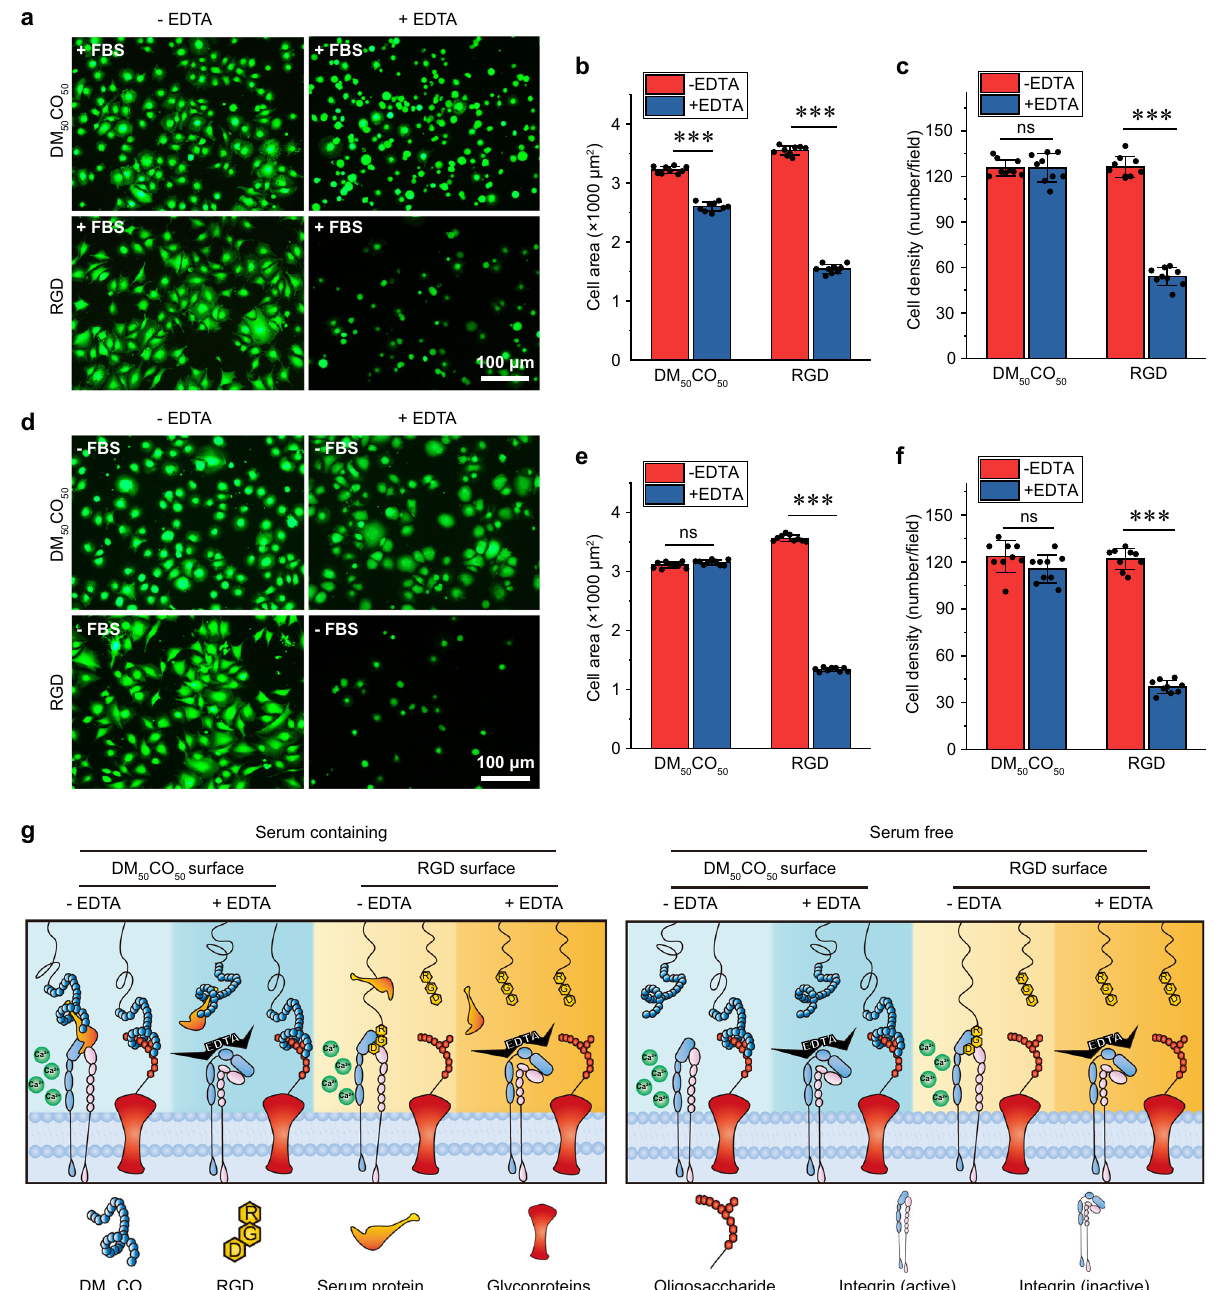
Fig. 4 Cells adhesion via both integrin-dependent and -independent mechanisms. a Fluorescent micrographs of live/dead stained cells, b cell area analysis, and c cell density analysis, of cell adhesion to DM 50 CO 50 and RGD-modi fi ed surfaces in serum-containing media for 3 h, with or without EDTA treatment. d Fluorescent micrographs, e cell area analysis, and f cell density analysis, of cell adhesion to DM 50 CO 50 and RGD-modi fi ed surfaces in serum- free media for 3 h, with or without EDTA treatment. g Cell adhesion mechanisms of DM 50 CO 50 and RGD-modi fi ed surfaces in different conditions. Data in ( b , c , e , f ) represent mean ± s.d. ( n = 9). Statistical analysis: two-tailed t -test, *** p < 0.0001, ns = not signi fi